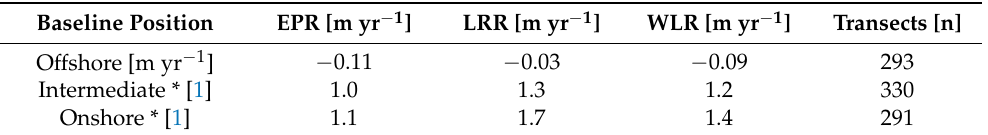
Table 5. Aggregated mean values of EPR, LRR and WLR, and the number of transects obtained using different baselines in ODSAS for site